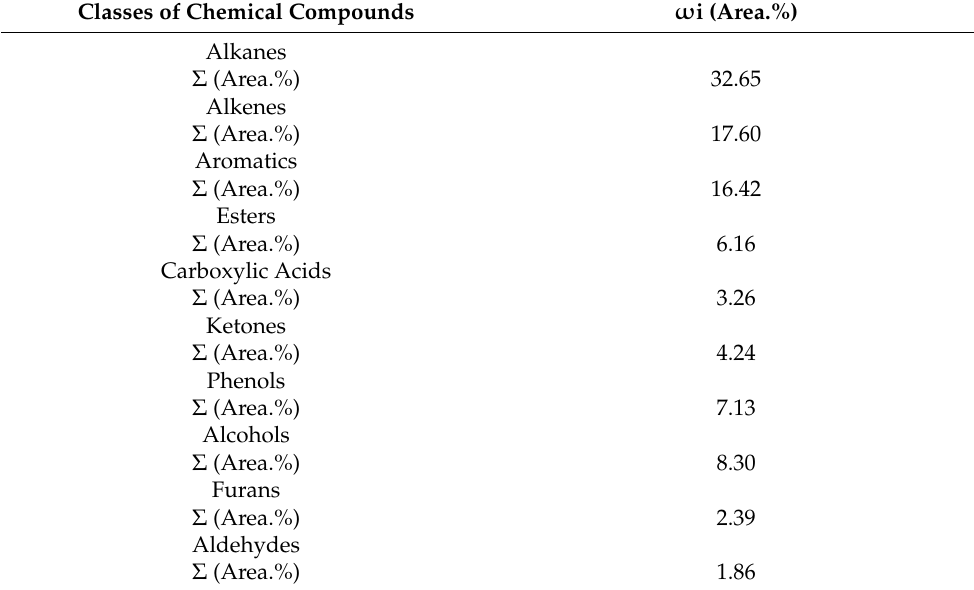
Table 11. Classes of compounds and summation of peak areas of hydrocarbons and oxygenates identified by CG-MS in light-kerosene-like fraction (175–200 ◦ C) after distillation of bio-oil obtained in pilot scale.